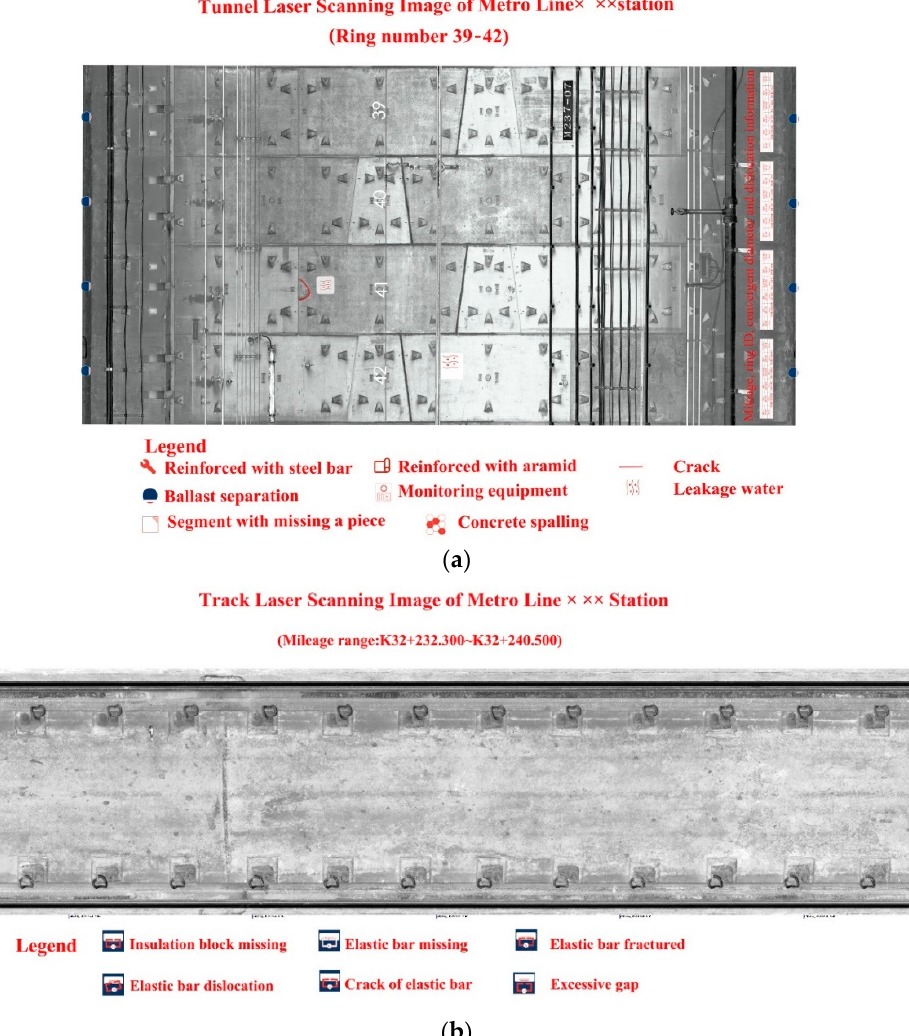
Figure 3. Tunnel and track thematic map: ( a ) tunnel thematic map and ( b ) track thematic map.